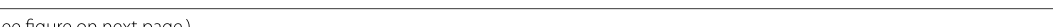
research(See figure on next Fig. 4 Phylogenetic tree based on the sequencing of internal transcribed spacer (ITS) region using UPGMA method (jukes and cantor model) performed with Mega 7 program for windows (Kumar et al., 2016). This research found 20 isolates of entomopathogenic fungi: 4 isolates placed within the group of Chaetomium sp., 3 isolates placed within the group of Aspergillus niger , 5 isolates placed within the group of Beauveria bassiana , 5 isolates placed within the group of Curvularia lunata , 1 isolate placed within the group of Aspergillus flavus , 1 isolate placed within the group of Penicillium citrinum , and 1 isolate placed within the group of Metarhizium anisopliae. A green round symbol